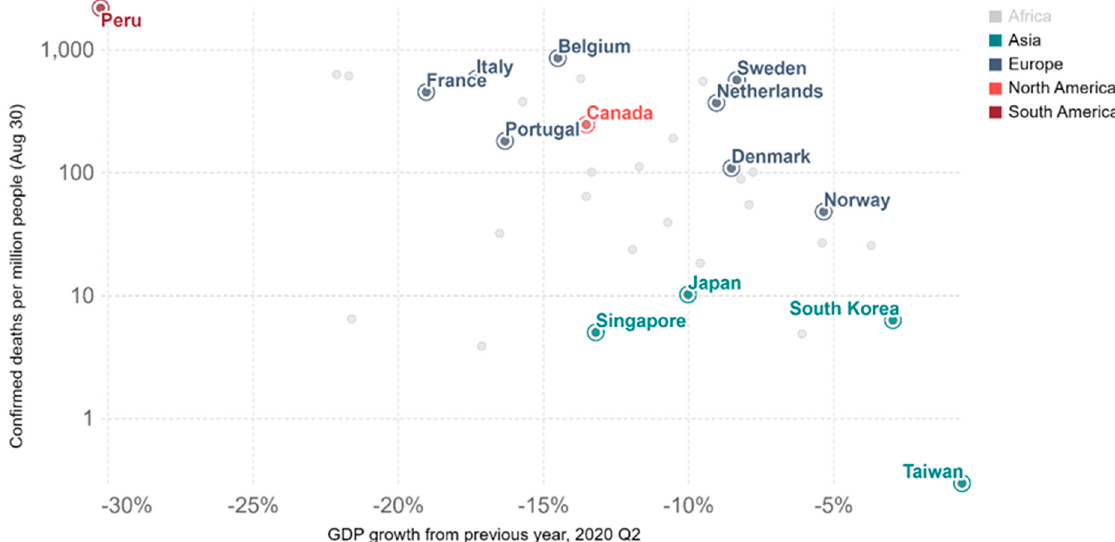
Figure 3. Economic decline in 2020 s quarter vs. confirmed deaths due to COVID-19. Source: Data from Johns Hopkins University CSSE via Our World in Data (https://ourworldindata.org (accessed on 9 January 2022)).